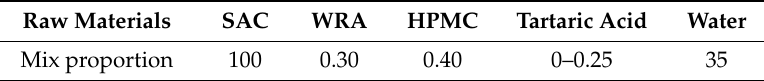
Table 2. The detailed mix proportion of raw materials (%).